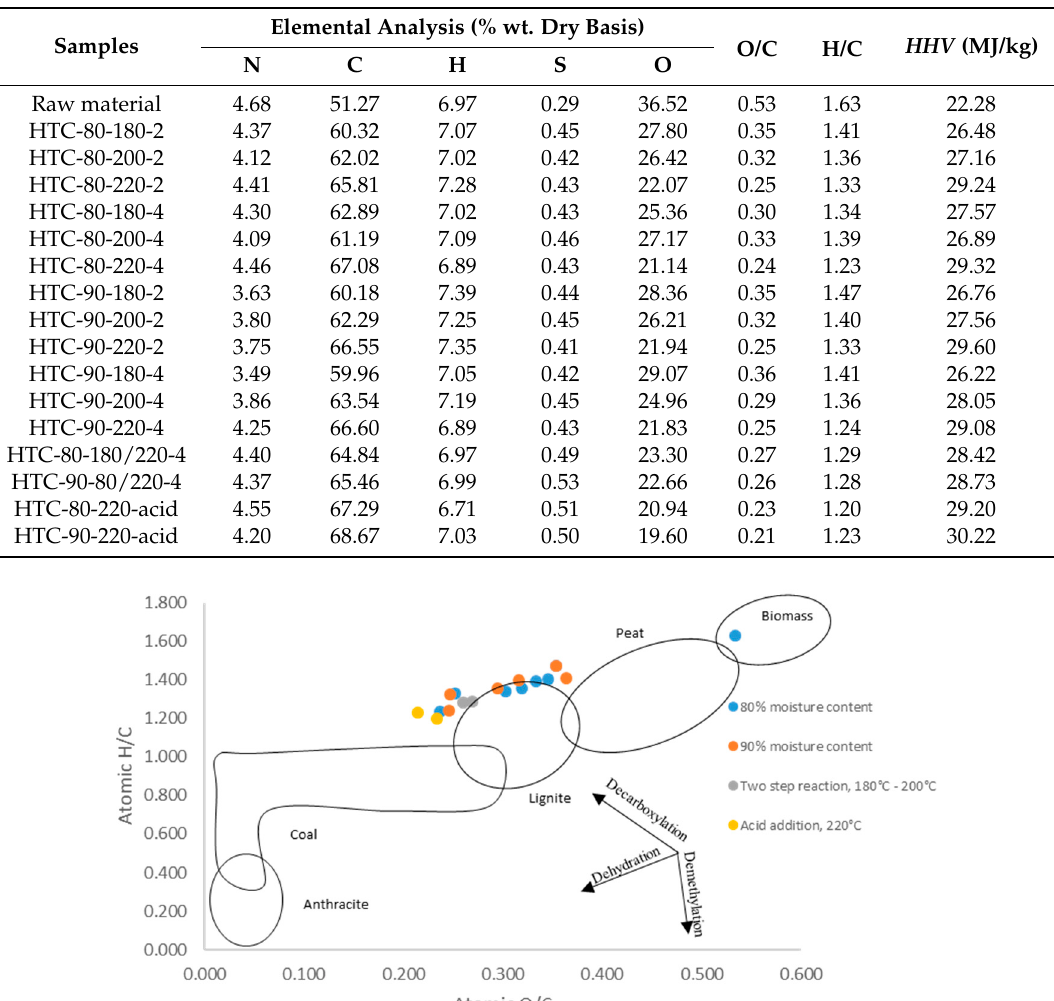
Table 4. Elemental analysis, O/C and H/C ratios and high heating values ( HHV ). Elemental analysis (% wt. dry basis) Samples N Raw material